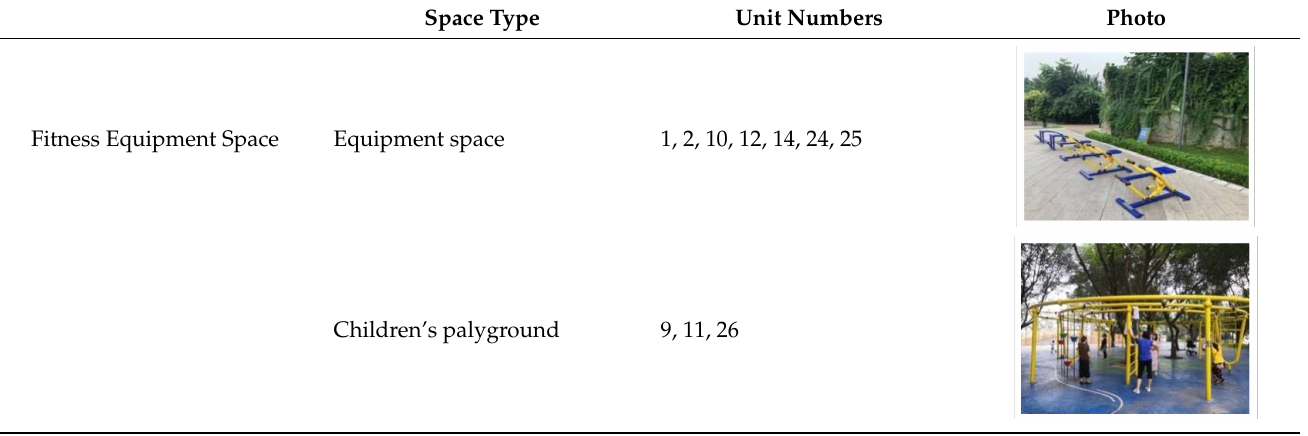
Figure 2. Location and layout of the three community sports parks in main city area. Rea color refers to the study units with numbers. Table 2. Different types of spaces’ corresponding unit numbers and